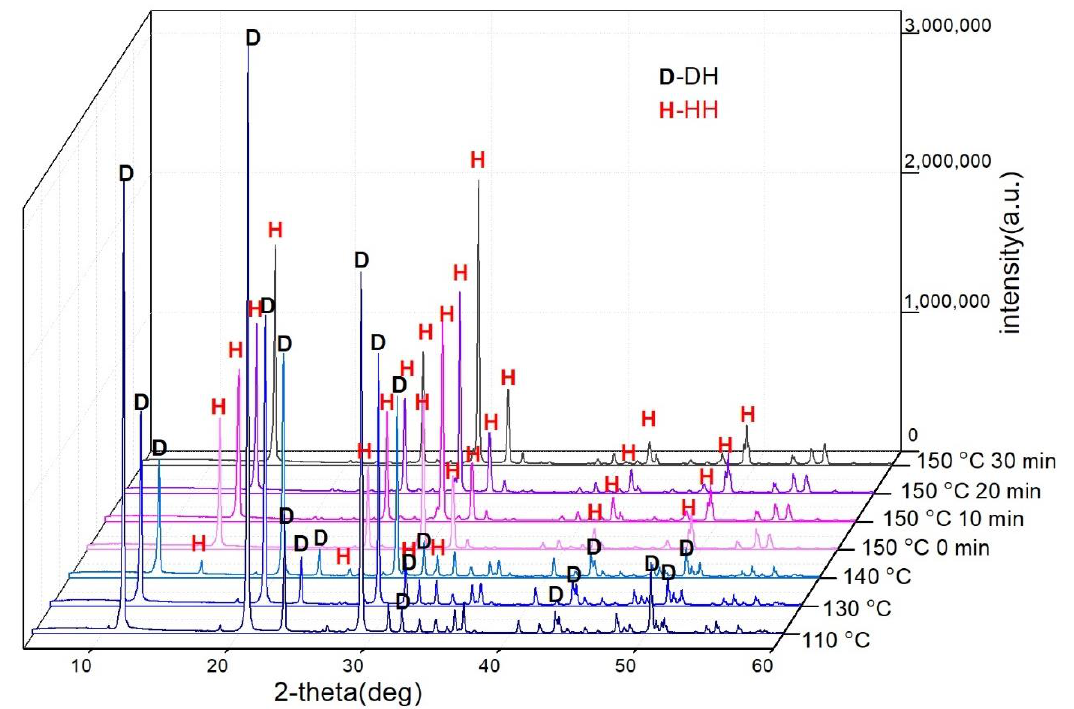
Figure 3. XRD patterns of the samples corresponding to the reaction stages of 110 °C, 130 °C, 140 °C, 150 °C, 150 °C lasting for 10 min and 150 °C lasting for 30 min.